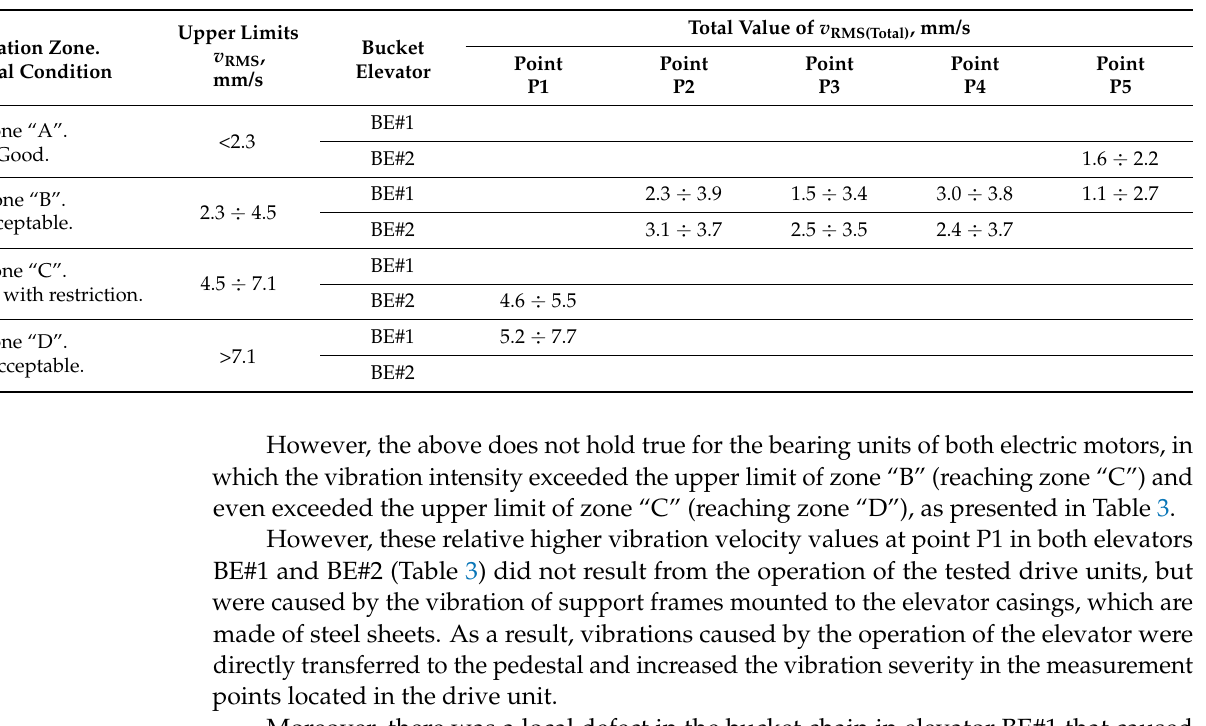
Total Value of v RMS(Total) , mm/s Point Point P2 P3